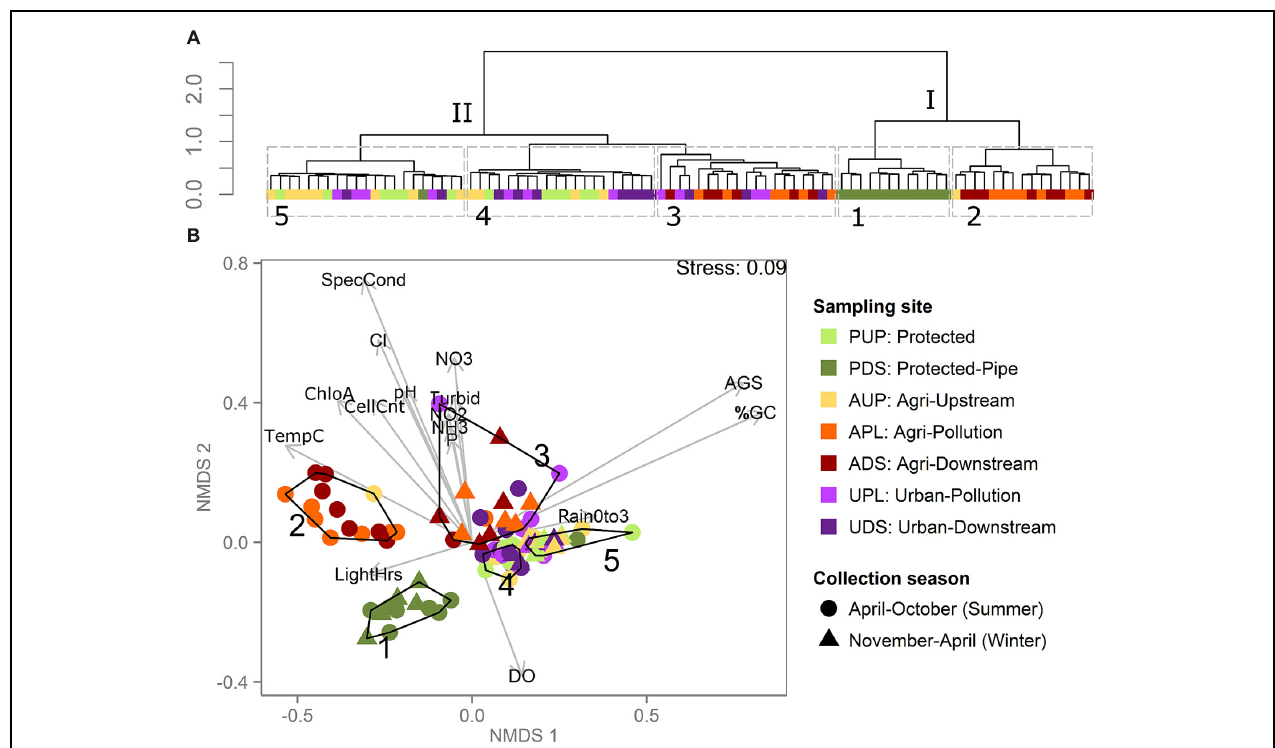
FIGURE 2 | Metagenomes clustered by reference-free k-mer analysis show effect of sampling site, weather conditions, and water chemistry. (A) Hierarchical clustering of samples based on metagenome k-mer composition. Each terminal node (leaf) is a sample, colored by sampling site. Roman numerals label major clusters, Arabic numerals label sub-clusters outlined in gray dashed lines. (B) NMDS plot based on k-mer abundance distributions in which each point represents a sample, colored by sampling site. Clusters outlined and numbered in black correspond to numbered clusters in (A) . Environmental variables were correlated with ordination axes using envfit and are displayed using gray arrows, where lengths of arrows correspond to the strength of the correlation between the variable and the ordination (only variables with p < 0.05 displayed) and direction corresponds to increasing value (e.g., samples closer to the bottom of the plot have higher DO). Environmental measures are abbreviated as in Table 2 . The percentage of nucleotides that are G or C is abbreviated as “%GC”. Sampling site is the major distinction among metagenomes from flowing surface water versus water collected from a reservoir-fed pipe (PDS). Among surface water samples, clustering reflects samples’ collection date, water chemistry and land